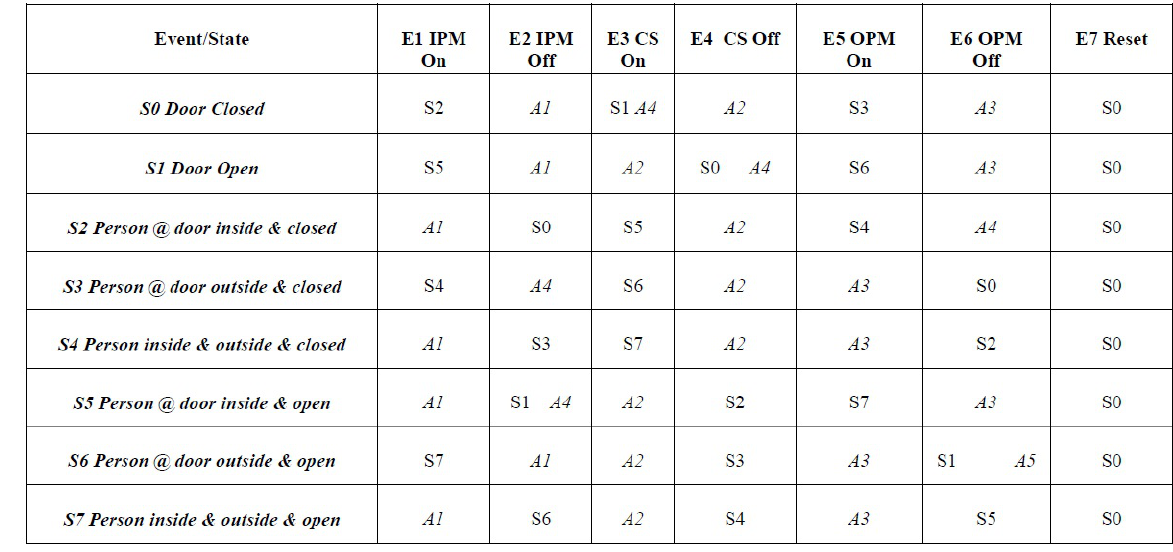
Figure 4: The structure of the NASM developed.